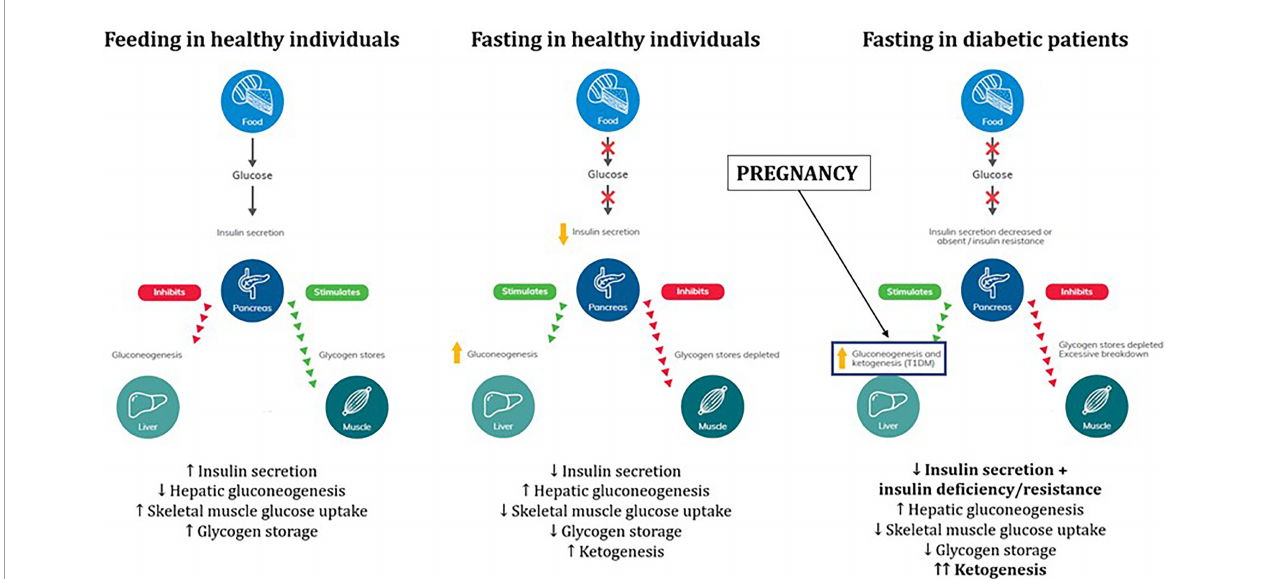
FIGURE 1 | Physiology of glucose and fuel metabolism during fasting in healthy individuals, pregnancy and diabetic patients. Adapted from International Diabetes Federation (IDF) 2021 guidelines on management of diabetes during Ramadan (38). Written permission obtained by Professor Mohamed Hassanein and Professor Bachar Afandi, lead authors of the IDF 2021